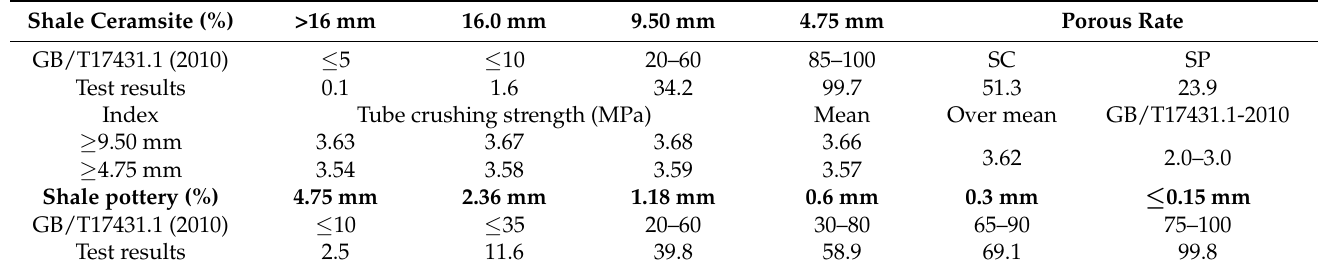
Table 1. Cumulative percentage by sieving and cylinder compressive strength for SC and SP [2].